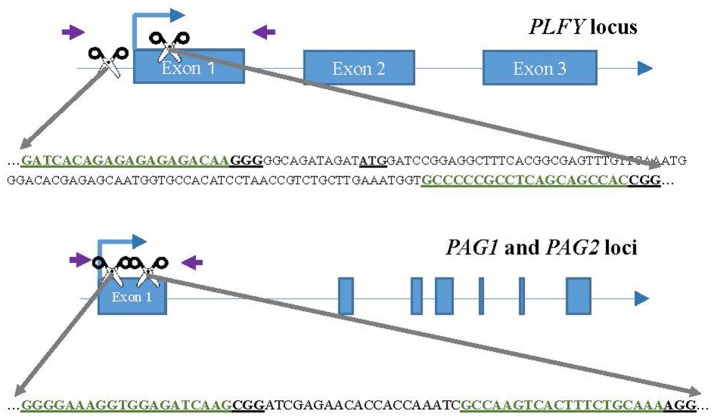
CRISPR/Cas9 sgRNA design and mutation detection in LFY and AG paralogs. Schematic representations of the target sites and the PCR assay for Sanger Sequencing. Exons and introns are represented by blue boxes and blue lines, respectively. The scissors indicate the target sites for each CRISPR/Cas9 nuclease. The purple arrows indicate the approximate location of the primers for sequencing. The target sites are colored in green inside the partial gene sequence. The underlined ATG in LFY indicates the location of the translation start codon.